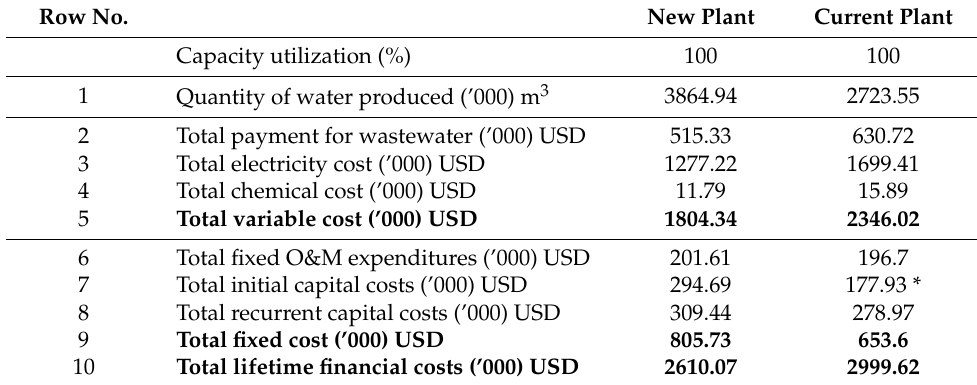
Table 7. Present value of the financial output and costs in terms of equal production in the two plants, in 2022 prices. Row No.